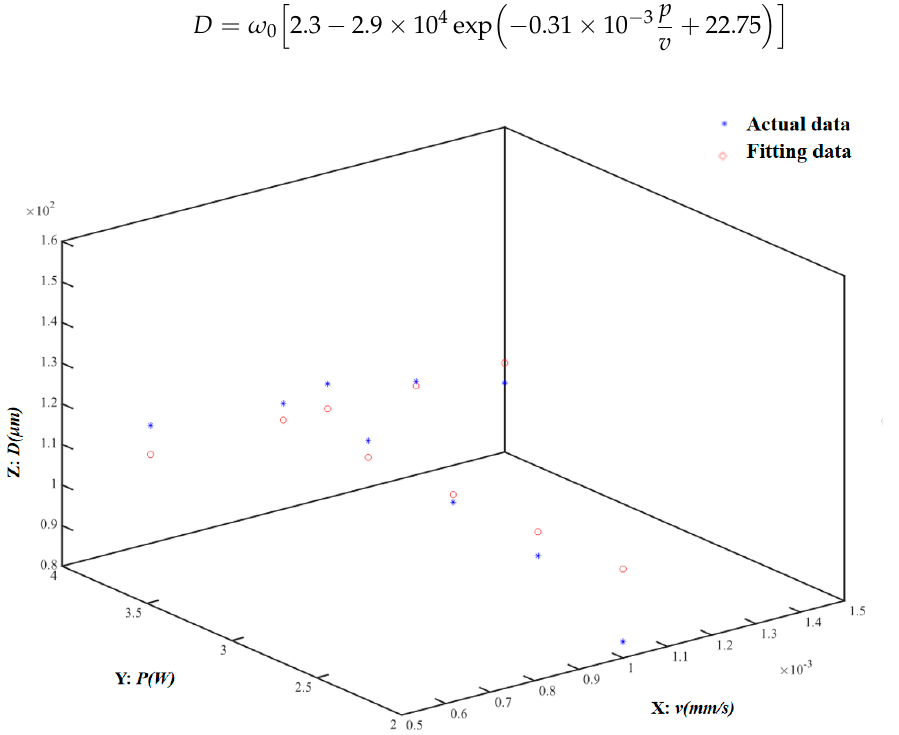
Figure 9. Width data fitting diagram.